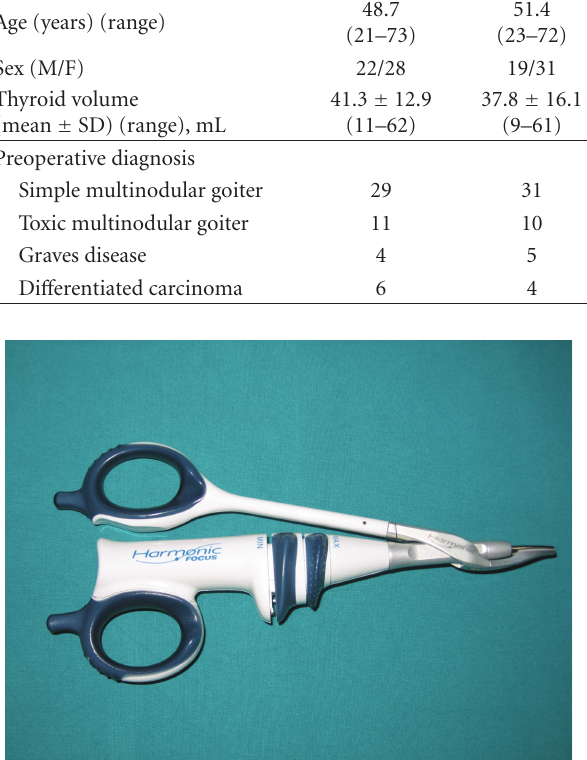
Figure 1: Focus Ultracision Harmonic Scalpel (Ethicon Endo-Sur- gery, Inc, Cincinnati, Ohio,